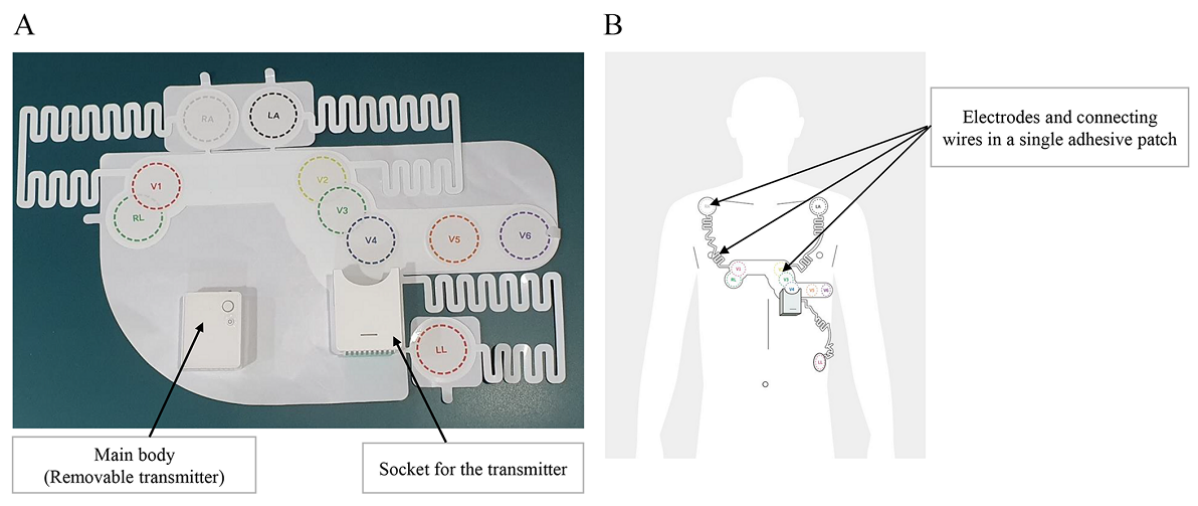
Figure 2. (A) Patchy-type wireless 12-lead electrocardiogram used for the intervention condition (HEALTHRIAN, Yuseong-gu, Daejeon, Republic of Korea). The device consists of two parts: a flexible patch with a socket and a transmitter. (B) Application of the device with the transmitter on the patient’s left chest